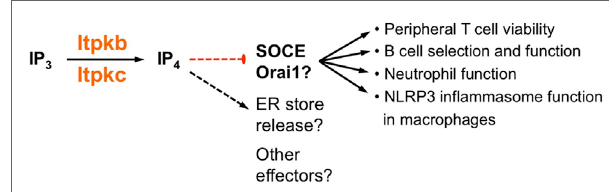
FigURe 5 | Itpkb controls immune cell biology by dampening store-operated Ca 2 + entry (SOCE). Several studies suggest that in peripheral T cells, developing and mature B cells, neutrophils and macrophages, Itpkb or Itpkc dampen SOCE through Orai channels (23, 39–42, 44, 59). This may be required for T cell viability, for preventing B cell anergy, and for ensuring neutrophil function. The ability of an exogenously provided cell-permeable IP 4 -ester to reduce SOCE very quickly after administration would be consistent with direct SOCE inhibition through IP 4 (39, 59). However, variably affected ER store release and previously published, complicated roles for Itpks, IP 3 , IP 4 , and IP 4 metabolites in controlling Ca 2 + mobilization in mammalian cells could point to alternate mechanisms and possible other effectors (8, 45, 60, 61). For more detailed discussions, see text.